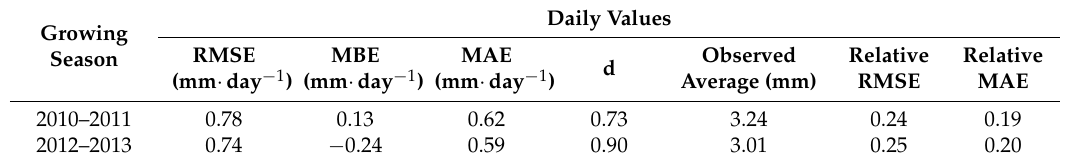
Figure 7. Daily and weekly values of measured and modeled actual evapotranspiration (ET c ) for both seasons. Modeled ET c values were simulated using the remote sensing-based water balance models. Table 3. Statistical measures for the comparison between the measured and modeled daily crop evapotranspiration using the remote sensing-based water balance model.